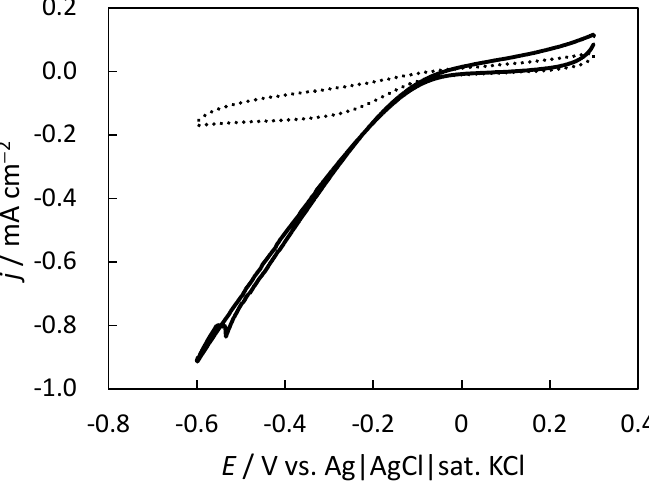
Figure 3. Cyclic voltammograms of the Pt-mesh electrode. The scan rate was 20 mV s − 1 . Measurements were conducted at room temperature (ca. 25 °C) under quiescent and atmospheric conditions. The Pt mesh was placed at the gas–liquid interface (solid line) and immersed in the solution (dotted line).